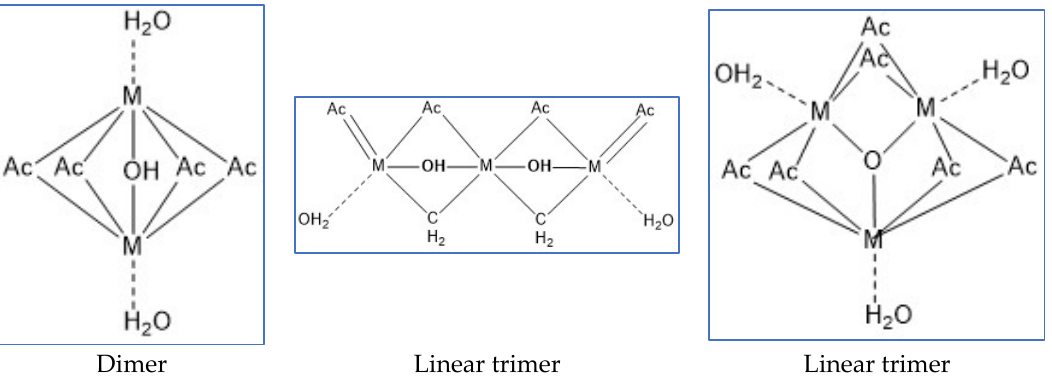
Figure 2. Synthetic product structure